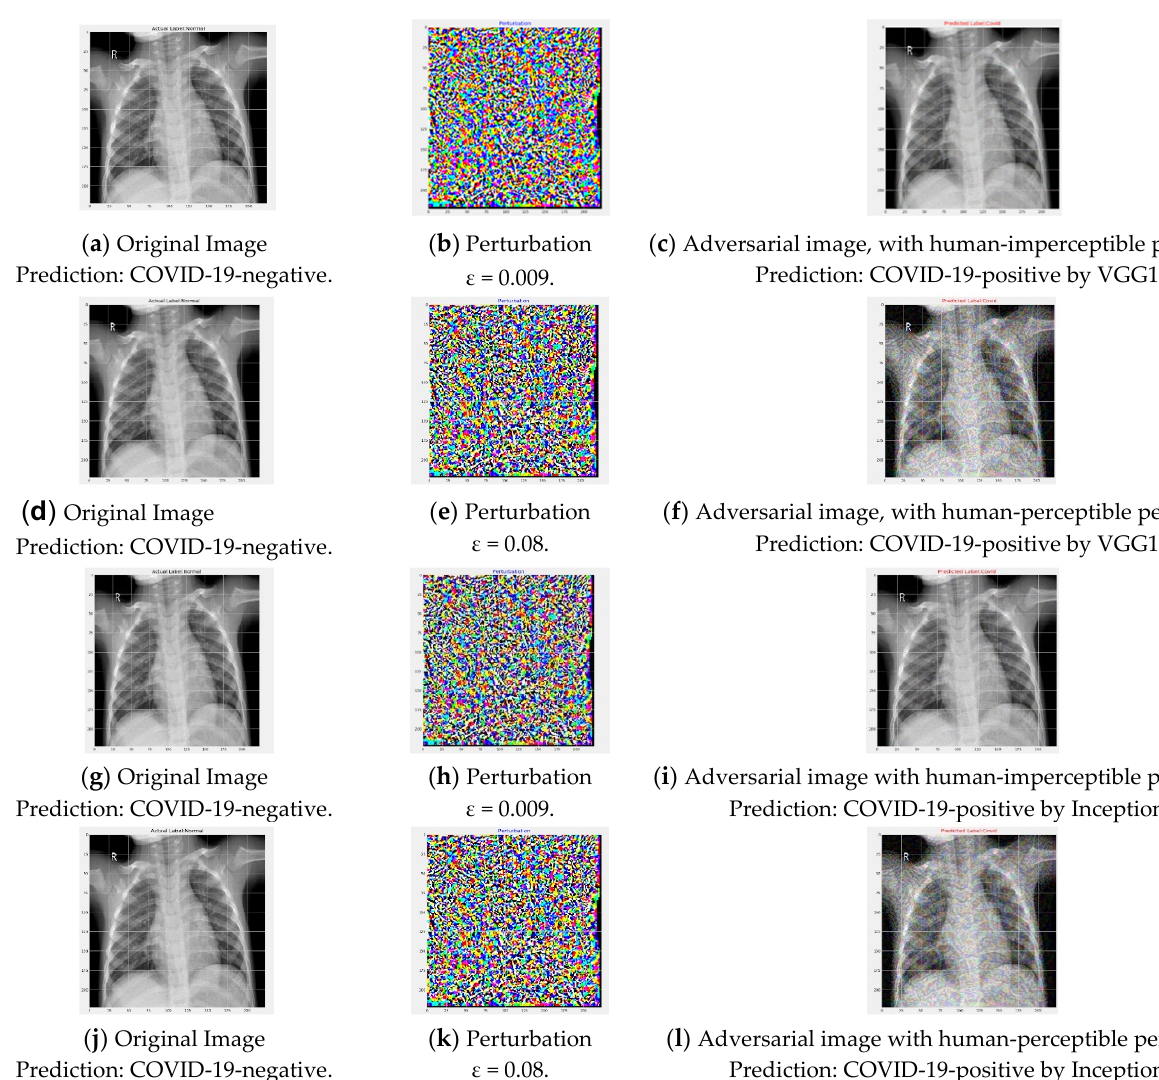
Figure 6. Original image ( left column ), perturbation ( middle column ), and corresponding misclassified adversarial chest X-ray images generated using FGSM attack for VGG16 and Inception-v3.